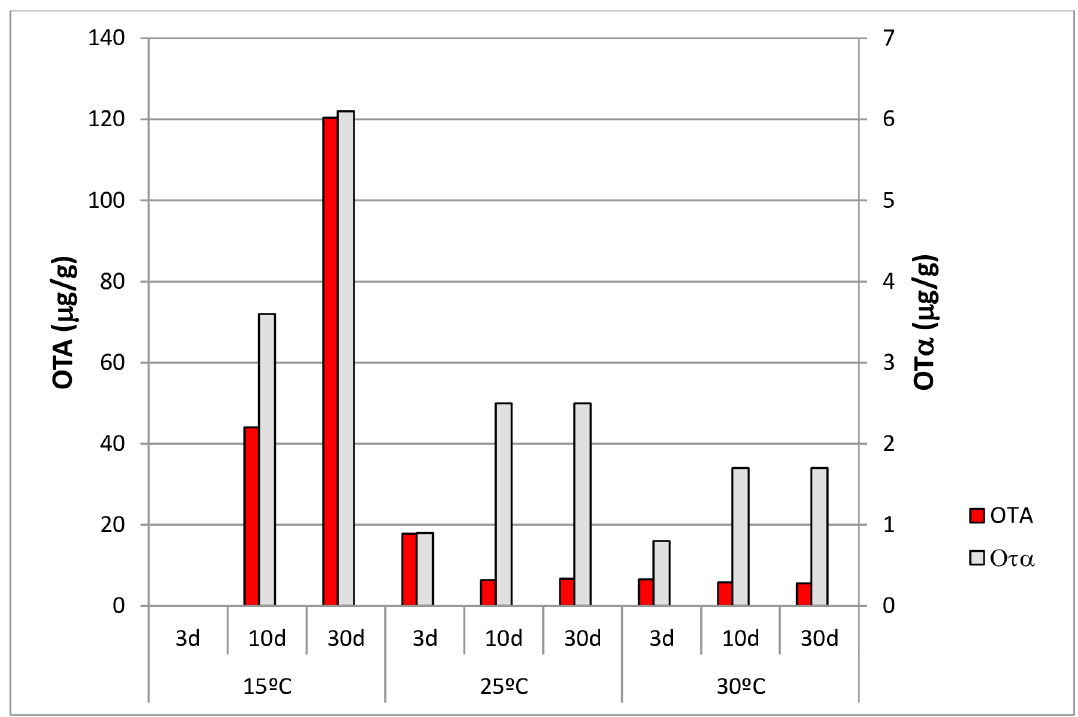
Fig 4. Mean OTA and OT α concentrations produced by the thirteen OTA-producing strains at each temperature and incubation time